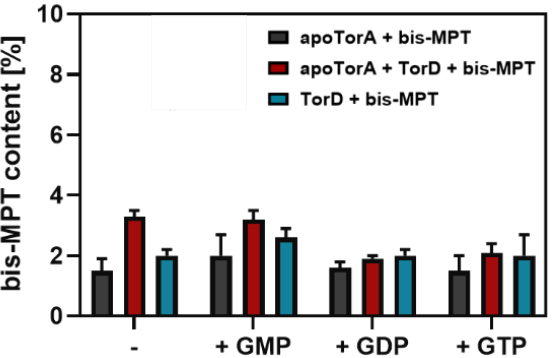
Figure 4. Effect of the presence of TorD and effect of free nucleotides in the reconstitution mixture on the insertion of bis-Mo-MPT into apo-TorA. Here, 1.3 µM apo-TorA, 2 µM TorD or both were incubated with bis-Mo-MPT isolated from 30 µM YdhV, and 50 mM GMP, GDP or GTP was added prior to the reconstitution mixture. Bis-Mo-MPT was detected in form of its fluorescent oxidation product dephospho-FormA.